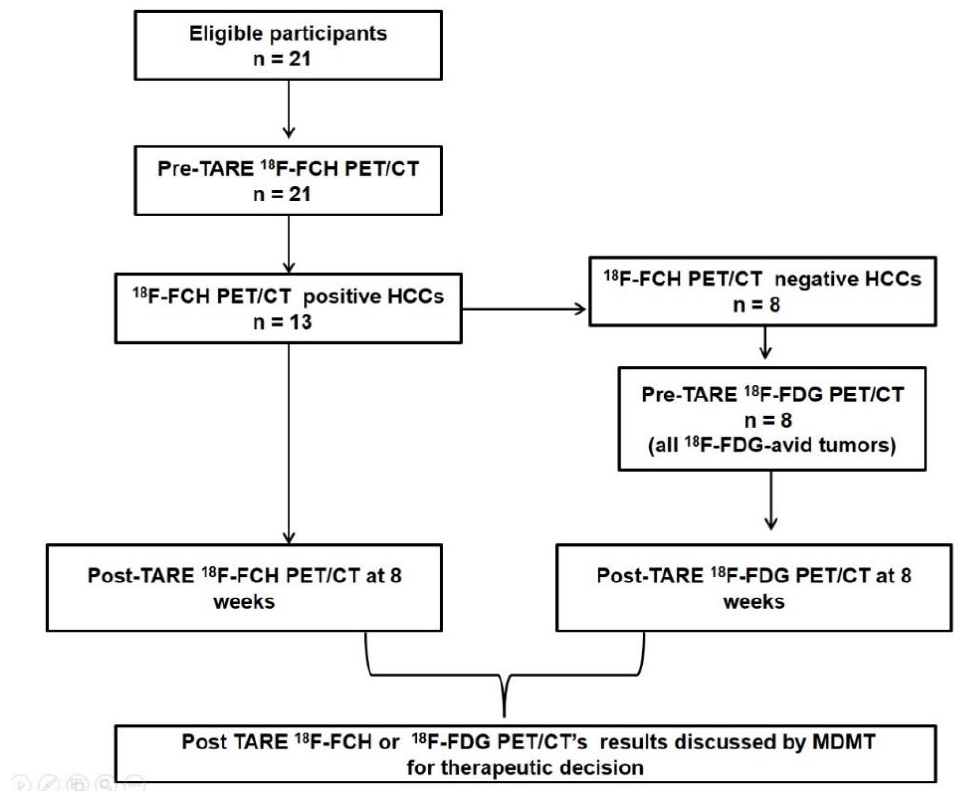
Figure 1. Diagnostic flow chart illustrating study